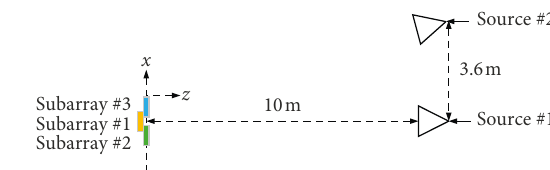
Figure 13: Experiment setup for the data-rate